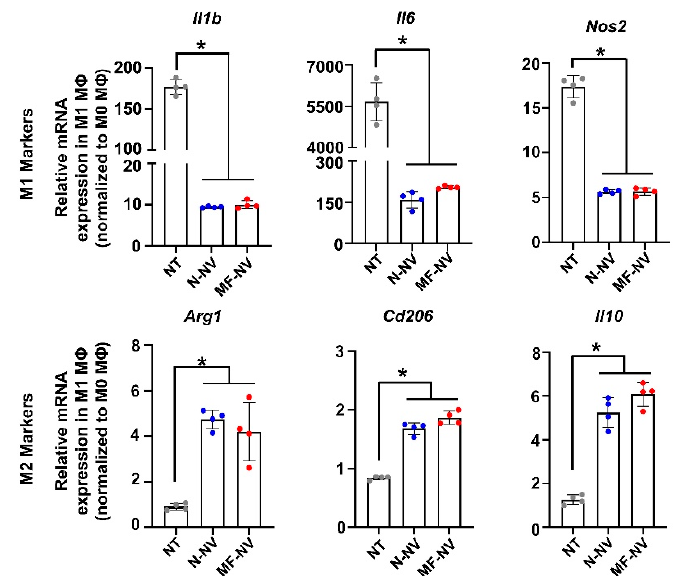
Figure 3. In vitro neuroprotective effects of NVs. ( A ) Representative images of viable and nonviable PC12 cells stained by fluorescein diacetate (FDA)/ethidium bromide (EB) after treatment. Scale bars, 100 μ m. ( B ) Relative cell viability as evaluated by the CCK assay after the treatment (n = 4 per group). ( C ) Relative mRNA expression levels of apoptotic ( Bax ) and anti-apoptotic ( Bcl2 ) genes in PC12 cells after treatment, as evaluated by qRT-PCR (n = 4 per group). NT indicates no treatment. * p < 0.05 by using one-way ANOVA followed by post-hoc Bonferroni test. All values are mean ± SD.